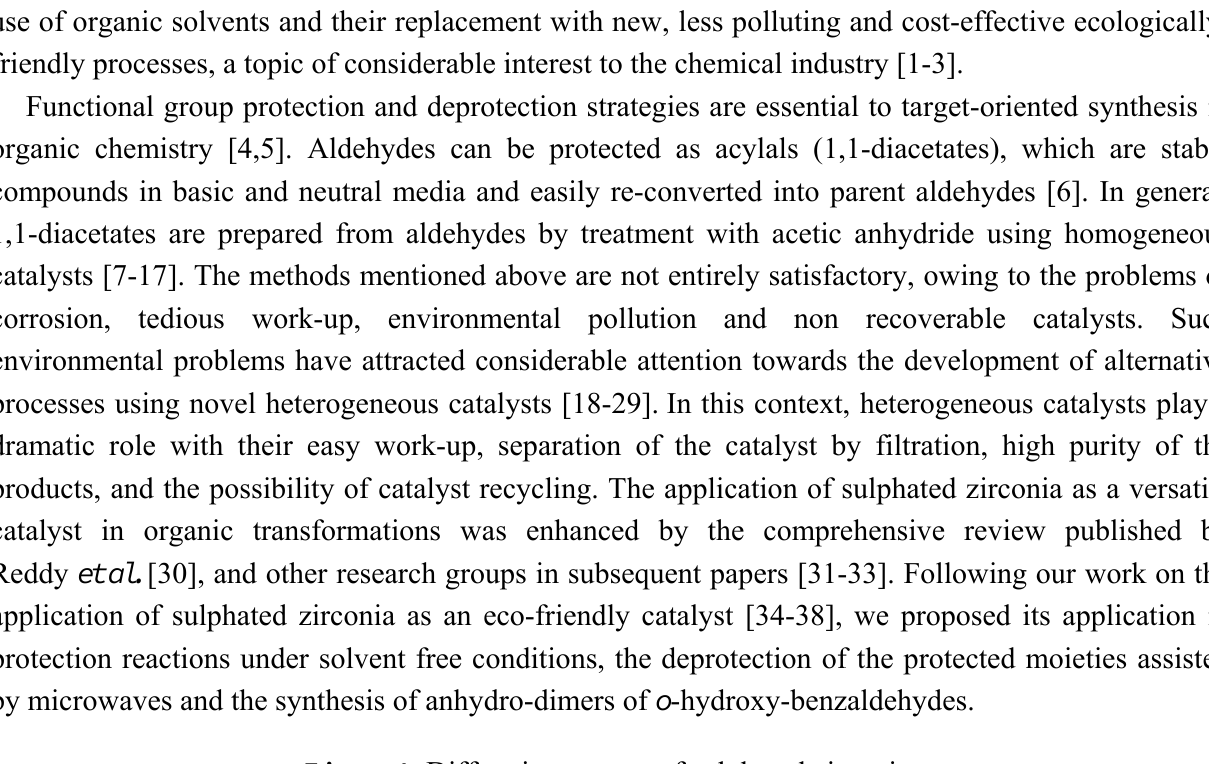
Figure 1. Diffraction pattern of sulphated